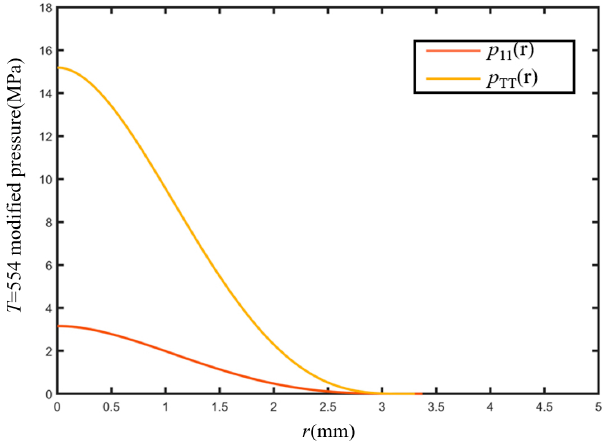
Figure 12. Third discrete pressure correction curve ( T = 554 N, n = 3). For the constraint method, the 3rd discretization requires more compensation of contact pressure. The discrete contact pressure curves of higher orders such as 5th, 8th, 100th and 500th order, under a tangential load of 0 N and 554 N, were calculated. With the increase of n , the amplitude of the second correction decreases obviously, and the correction amplitude is basically fixed when the order increases to 100, as shown in Figure 13.